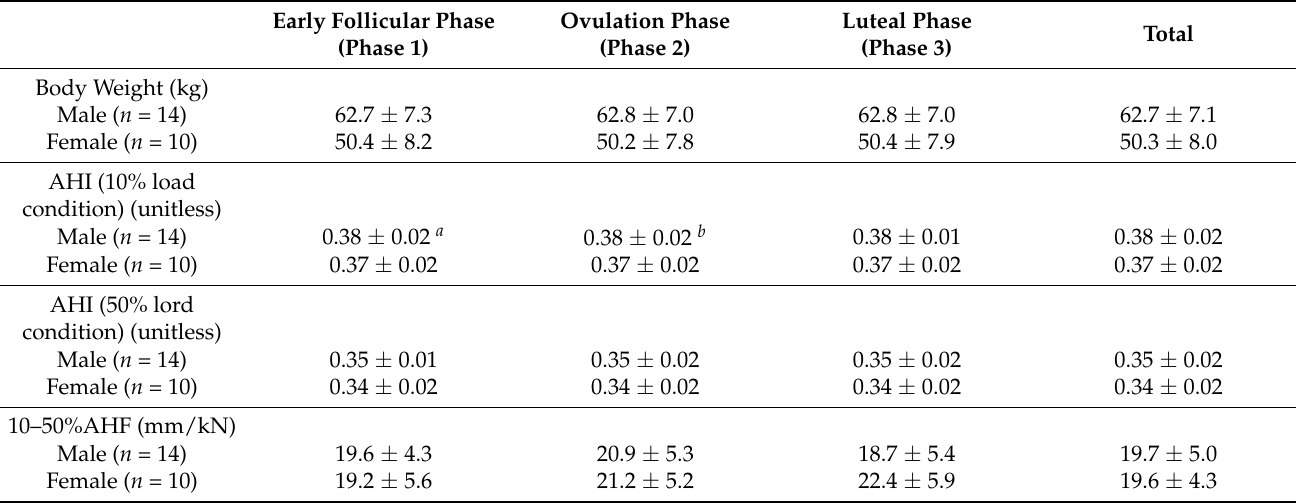
Table 2. Changes in AHI and AHF during the menstrual